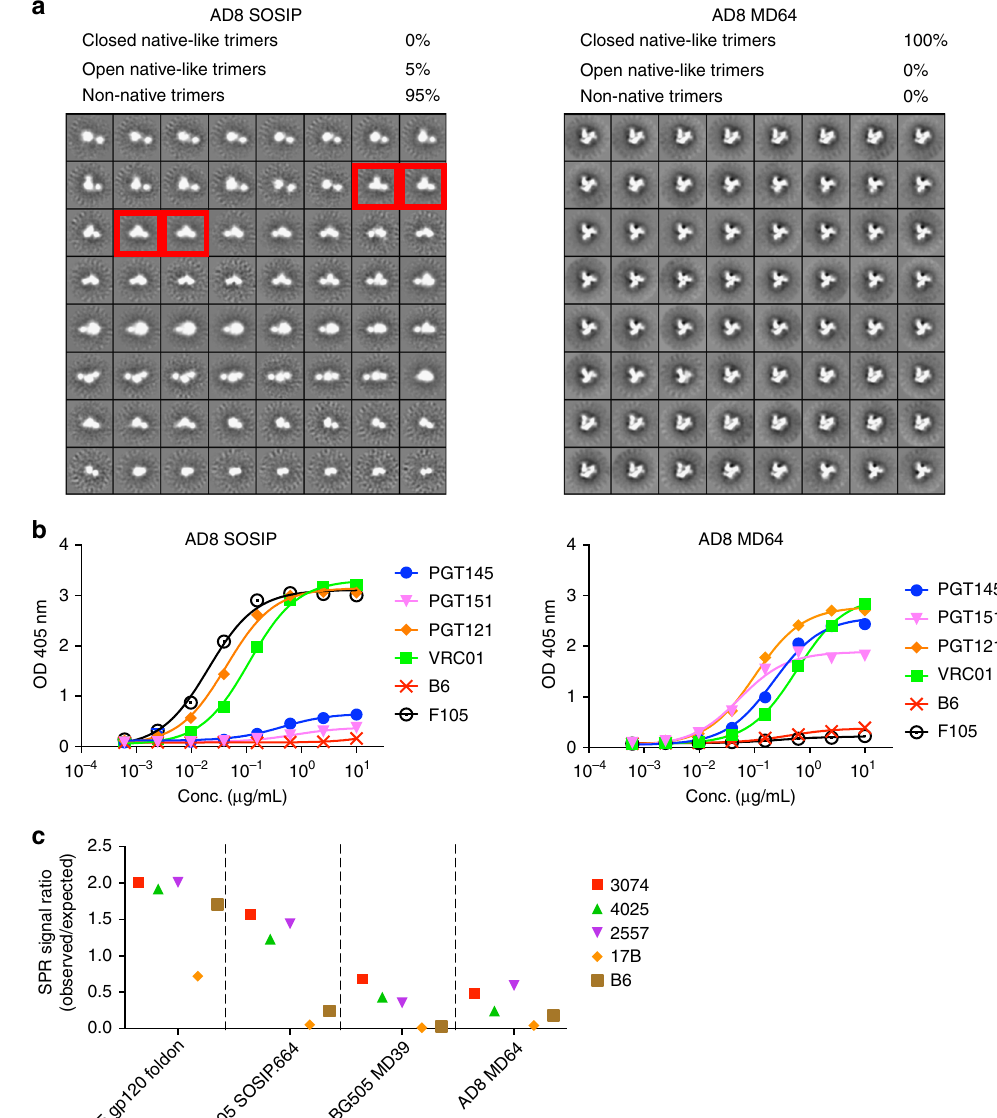
Fig. 5 Structural and antigenic assessment of AD8 trimer with different stabilization designs. a 2D class averages from negative-stain EM analysis of AD8 SOSIP trimer and AD8 MD64 trimer, classi fi ed as closed native-like, open native-like, or non-native. Red boxes indicate examples of open native-like trimers. b ELISA-binding curves for bnAbs and non-nAbs against AD8 SOSIP and the AD8 MD64 trimer. ELISA antigens are labeled on top of the plots, and the antibodies are labeled in the legend. c SPR signal ratio for non-nAbs binding to AD8 MD64 trimers. The data are from one experiment and measurements are done in